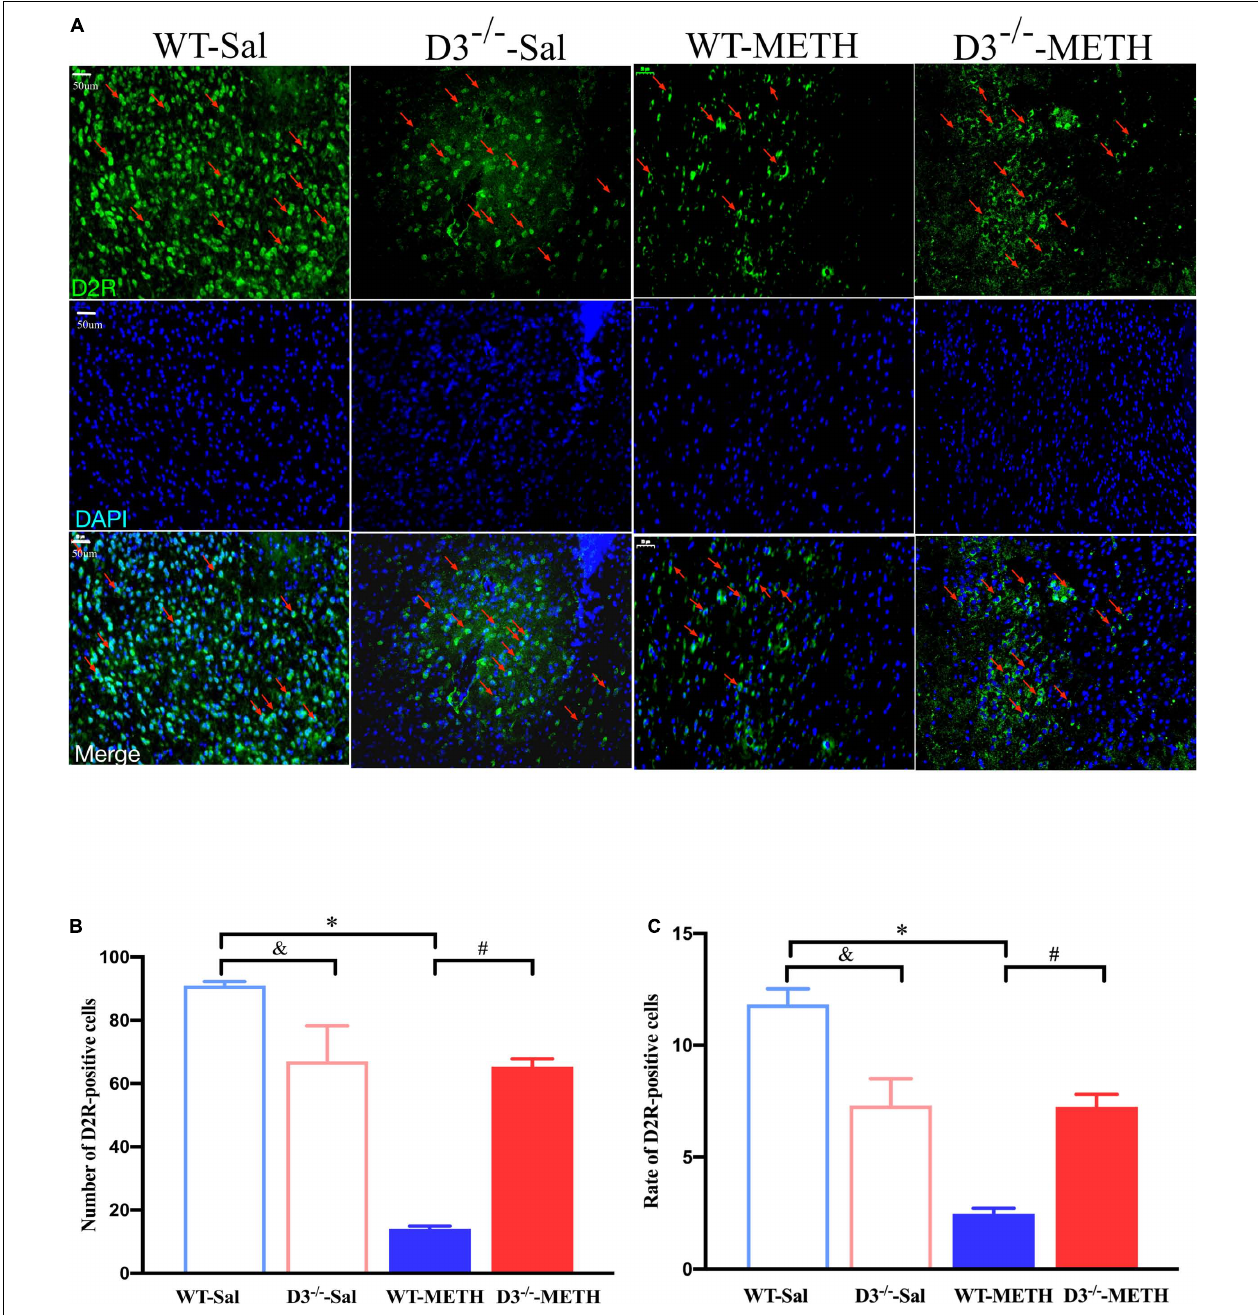
FIGURE 5 | Knockout of dopamine D3 receptor gene blocked the changes of D2R-positive cells in the NAcsh of METH-sensitized mice. (A) Fluorescent staining of the dopamine D2 receptor in the NAcsh. The red arrows indicated the D2R-positive cells. Scale bars = 50 µ m. (B,C) Quantification of the number (B) and rate (C) of D2R-positive cells in the NAcsh of the four groups of mice ( n = 3 mice each). ∗ P < 0.05 compared with the same genotype in saline group; # P < 0.05 compared with same-dose WT mice; & P < 0.05 compared with the different genotype in saline group. Values are presented as mean ± SEM. WT, wild type.